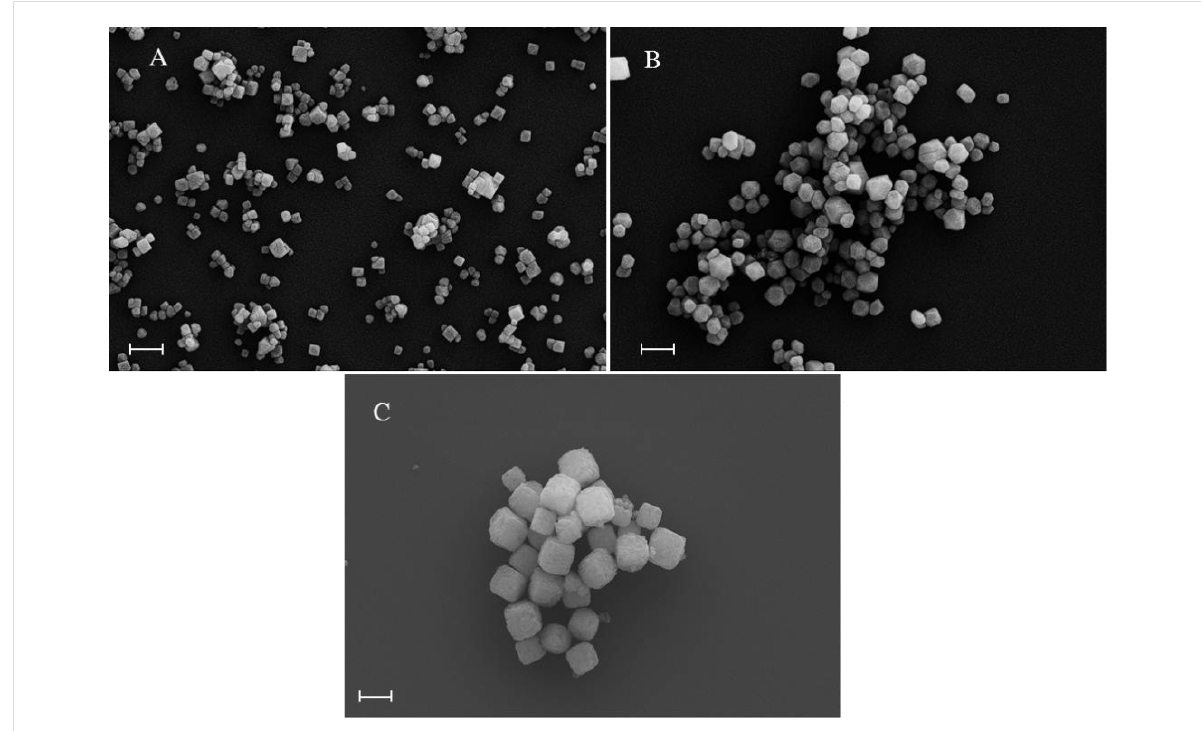
Figure 2: SEM images of the three morphologies of nanoparticles explored in this work. A certain size distribution of the particles was achieved with the synthesis method described in the text. The diameters vary from 50–100 nm for (A), 100–150 nm for (B) and 200–250 nm for (C). The shape varied from cubic (A) to polyhedral (B) and oblate cubic (C). The scale bar for all images is 200 nm.